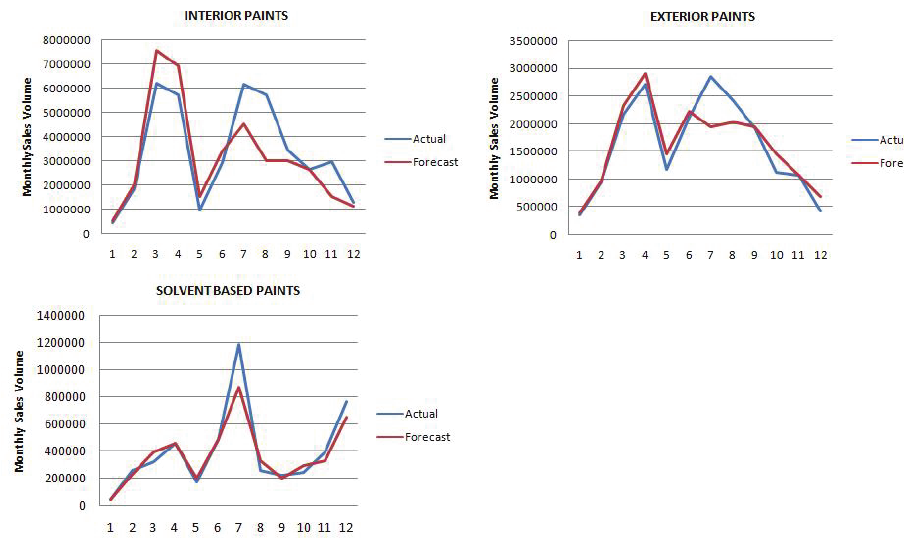
Fig. 7. Forecast generated by the proposed hybrid FRBS